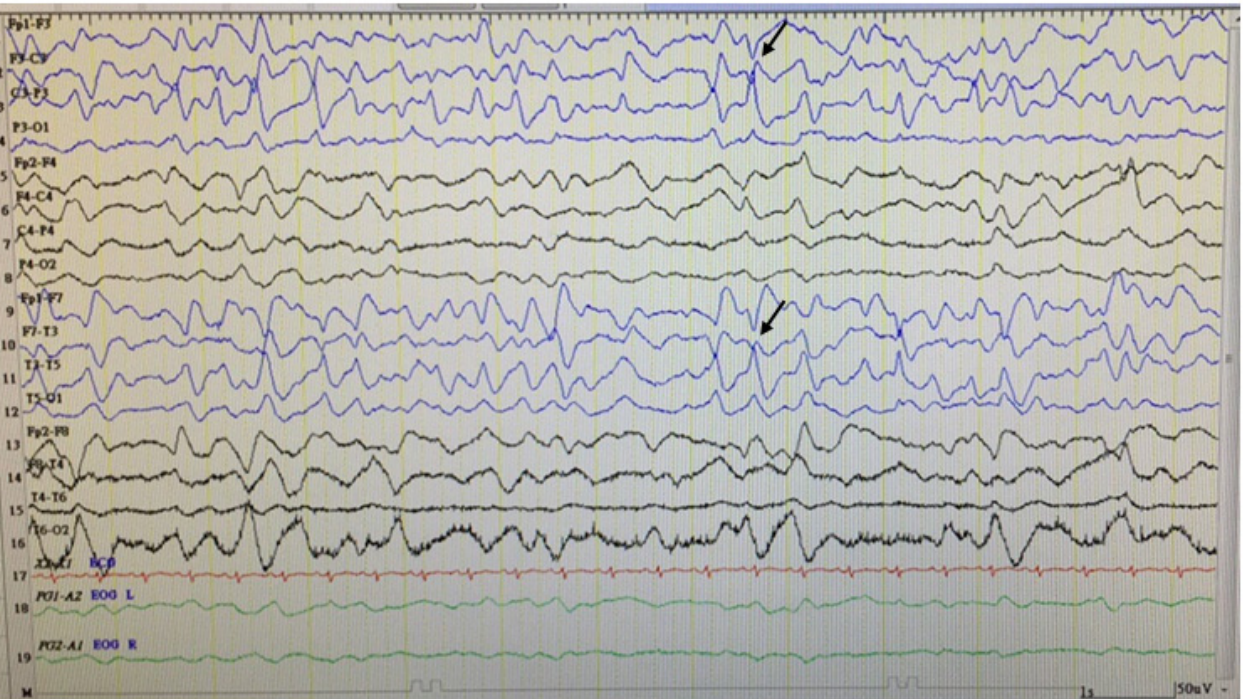
Figure 1. Sleep EEG of Case 1. It showed asymmetric slow background activities with focal discharges (arrows) from the left frontotemporal region.